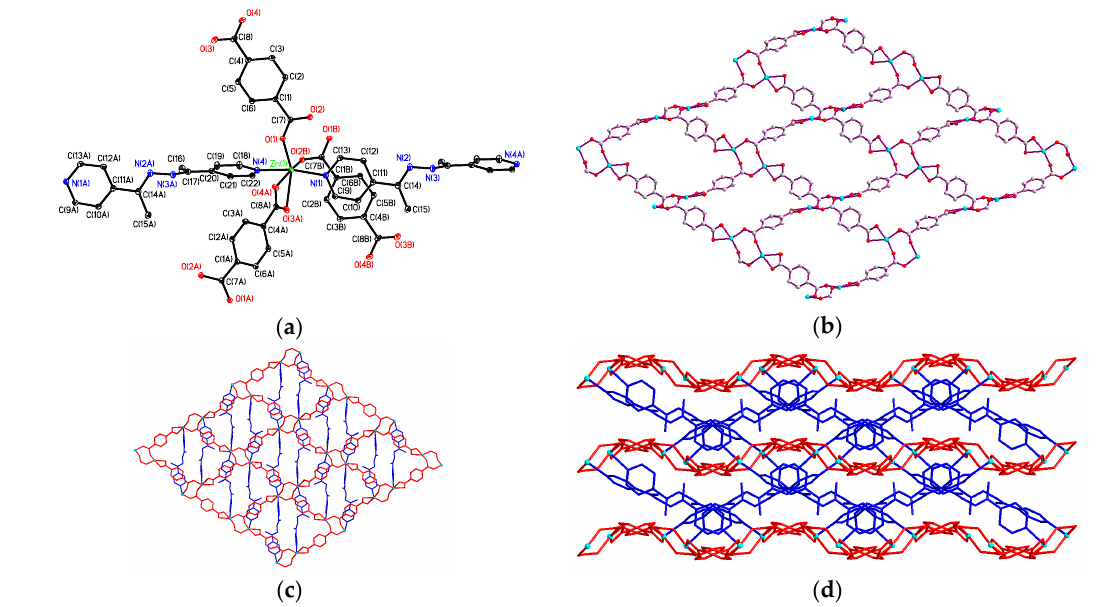
Figure 2. ( a ) Distorted octahedral coordination environments about Zn(II) ion in 2 with atom labelling scheme (ORTEP drawing, 30% thermal ellipsoids). The H atoms are omitted for clarity; ( b ) The 2D sinusoidal-like layered framework constructed by Zn(II) and bdc 2 − ligands with chelating/bidentate coordination mode viewing along the bc plane; ( c ) The 3D MOF constructed by the 2D [Zn–bdc] layers (red) bridged by 4-bpdh ligands (blue); ( d ) The 3D non-interpenetrating coordination network of 2 .